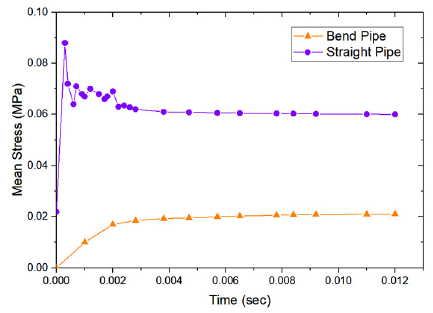
Figure 7. Skin bowl stress in the bend.